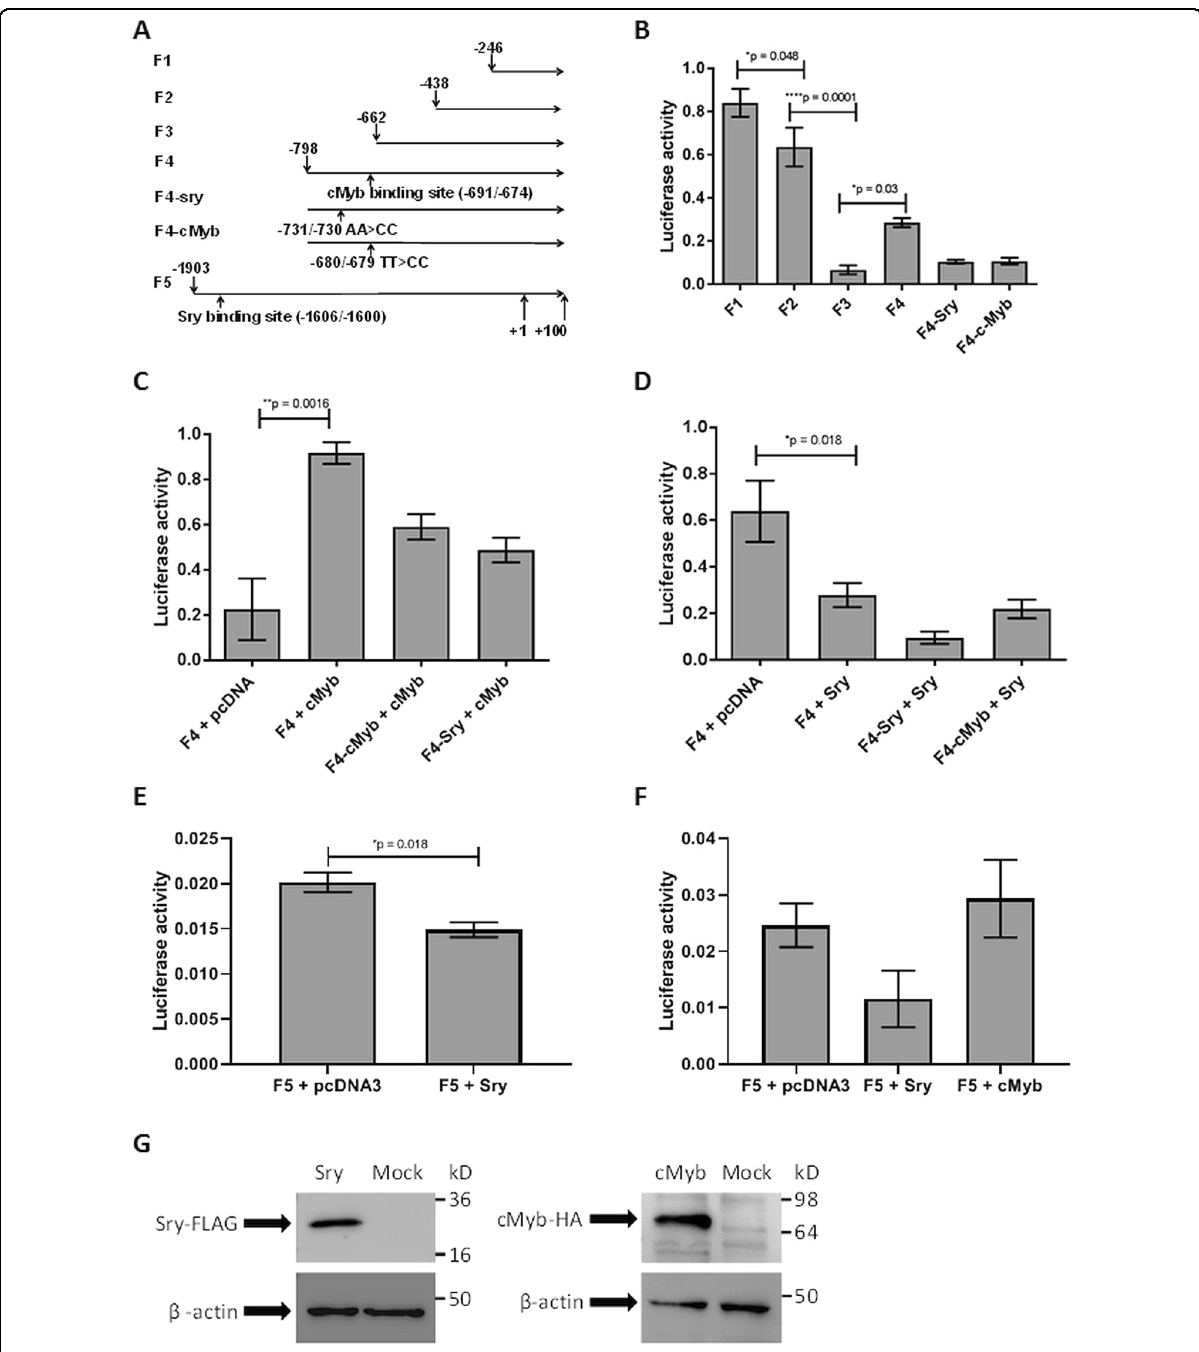
Fig. 1 c-Myb increases and SRY decreases the luciferase activity of the RANKL promoter region. a Different lengths of the RANKL proximal promoter region (F1, F2, F3, F4, F5) were cloned into the luciferase reporter vector pGL3-basic. Mutations were induced in the predicted SRY binding site ( − 731 AA> CC) and the predicted c-Myb binding site ( − 680 TT> GG) in the F4 vector using site-directed mutagenesis. b HOS (human bone osteosarcoma) cells were transfected with pGL3-F1/-F2/-F3/-F4/-F4-SRY/-F4-c-Myb and pRL normalization vector. Luciferase activities were measured 24h after transfection. c Luciferase assays of HOS cells cotransfected with the pGl3-F4 RANKL promoter region and pcDNA3 (empty) or c-Myb-HA and cotransfected with the mutated pGl3-F4 RANKL promoter regions and c-Myb-HA. d Luciferase assays of HOS cells cotransfected with the pGl3-F4 RANKL promoter region and pcDNA3 (empty) or Sry-FLAG and cotransfected with the mutated pGl3-F4 RANKL promoter regions and Sry-FLAG. e Luciferase assays of HOS cells cotransfected with the pGl3-F5 RANKL promoter region and pcDNA3 (empty) or Sry-FLAG. f Luciferase assays of human primary osteoblasts nucleofected with pGL3-F5 RANKL promoter region and pcDNA3 (empty) or Sry-FLAG or c-Myb-HA. g Western blotting of human bone osteosarcoma cells after transfection with Sry-FLAG or c-Myb-HA expression vector and of empty human bone osteosarcoma cells. All of the data are presented as the mean luciferase activities after normalization ± SEM. Asterisks indicate signi fi cant differences between luciferase